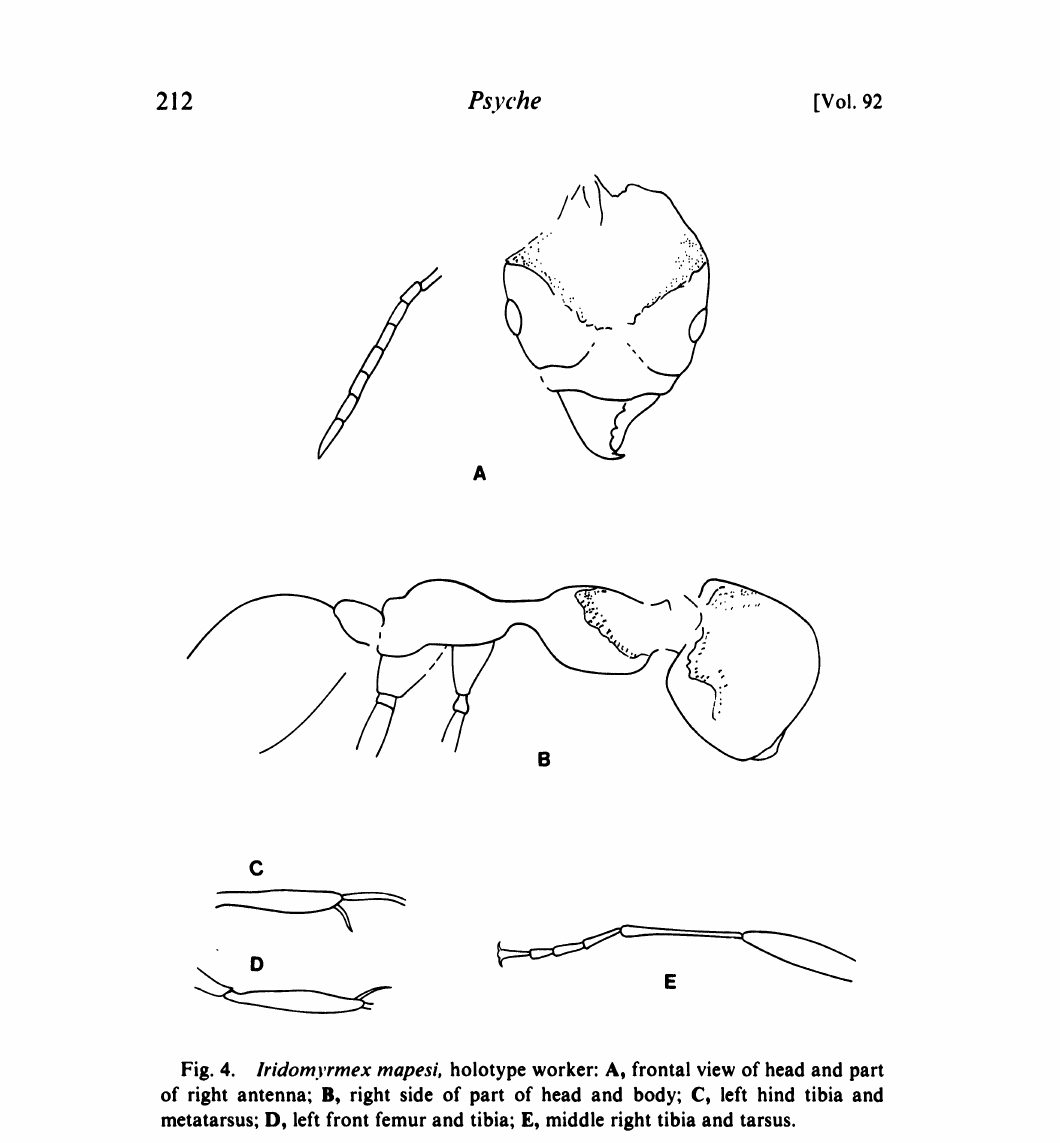
Fig. 4. lridomyrmex mapesi, holotype worker: A, frontal view of head and part of right antenna; !1, right side of part of head and body; C, left hind tibia and metatarsus; D, left front femur and tibia; E, middle right tibia and tarsus. of hairs surrounding the acidopore (Paratrechina and most other formicine genera possess the circlet) and in the absence of the upraised paired bristles on the alitrunk (possessed by Paratrechina and some species of A cantholepis and Brachymyrmex). Type species: Protrechina